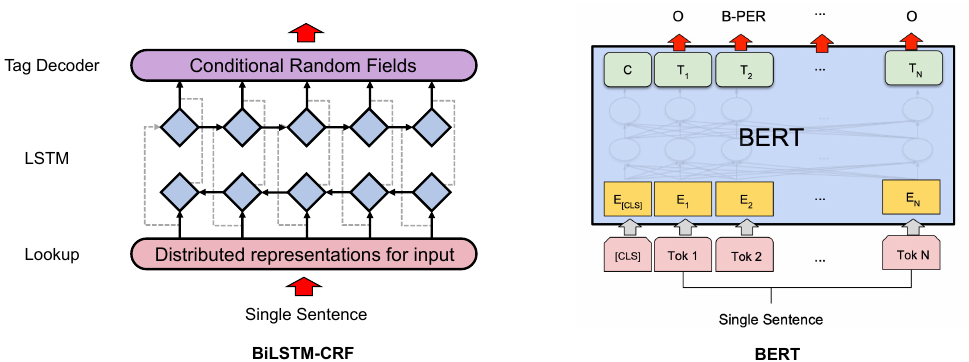
Figure 3. Comparison of BiLSTM and BERT in text-based named entity recognition.